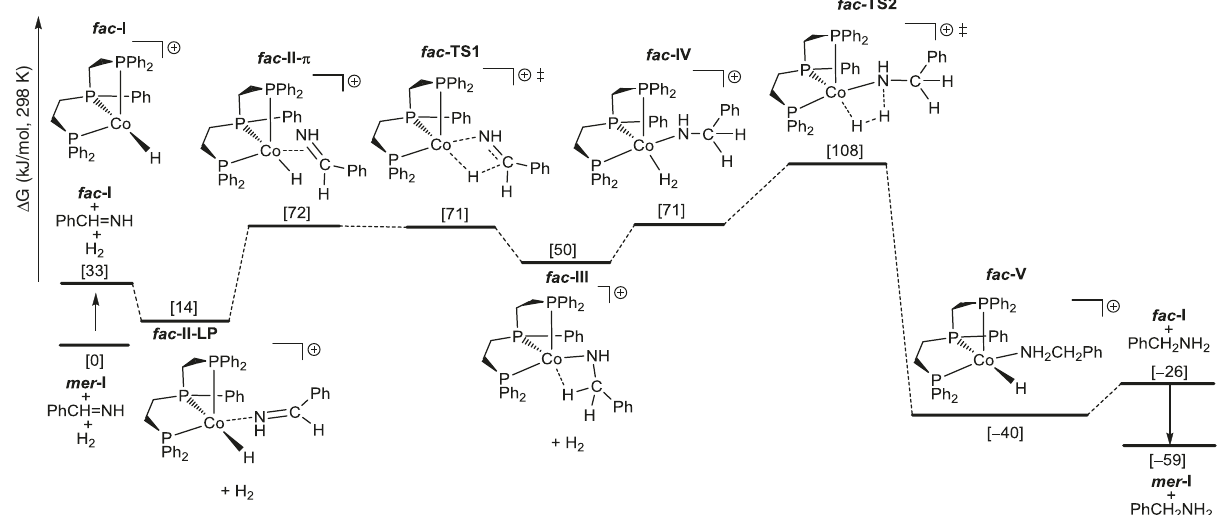
Fig. 5 Gibbs free energy surface for Ph − CH = NH hydrogenation in TFE solvation. Ph − CH = NH hydrogenation by using mono-cationic [triphos-CoH] + as active catalyst.